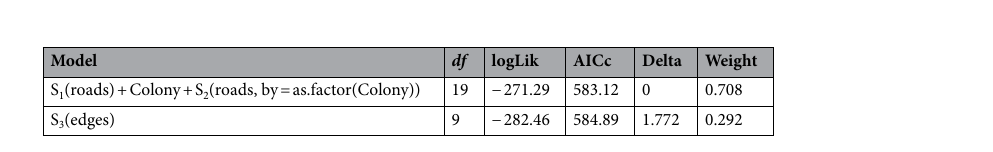
Table 3. Best models of flesh-footed shearwater breeding success on Lord Howe Island, with their degrees of freedom, Log-likelihood, AICc and delta AICc, and weighting from model averaging. Terms s(…) indicated a smoothed GAM